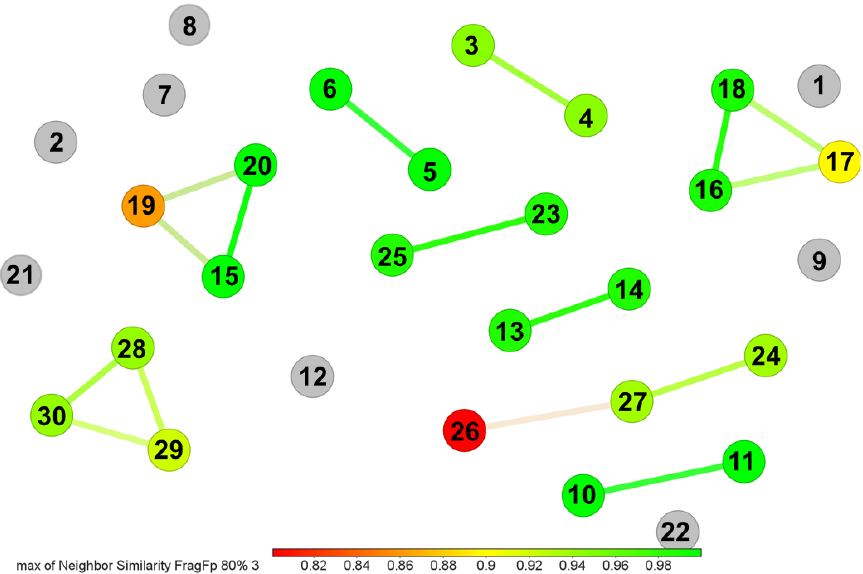
Figure 3. Similarity chart of Gordonia -derived compounds. The similarity between compounds was measured using the FragFp descriptor. Each dot represents a compound, and those joined by edges form a cluster. Gray dots represent compounds with unique fingerprints within the dataset ( n = 30). The number at each dot represents the compound ID, as shown in Figure 2. The color scale bar indicates the level of similarity from red (0.8) to green (1.0).